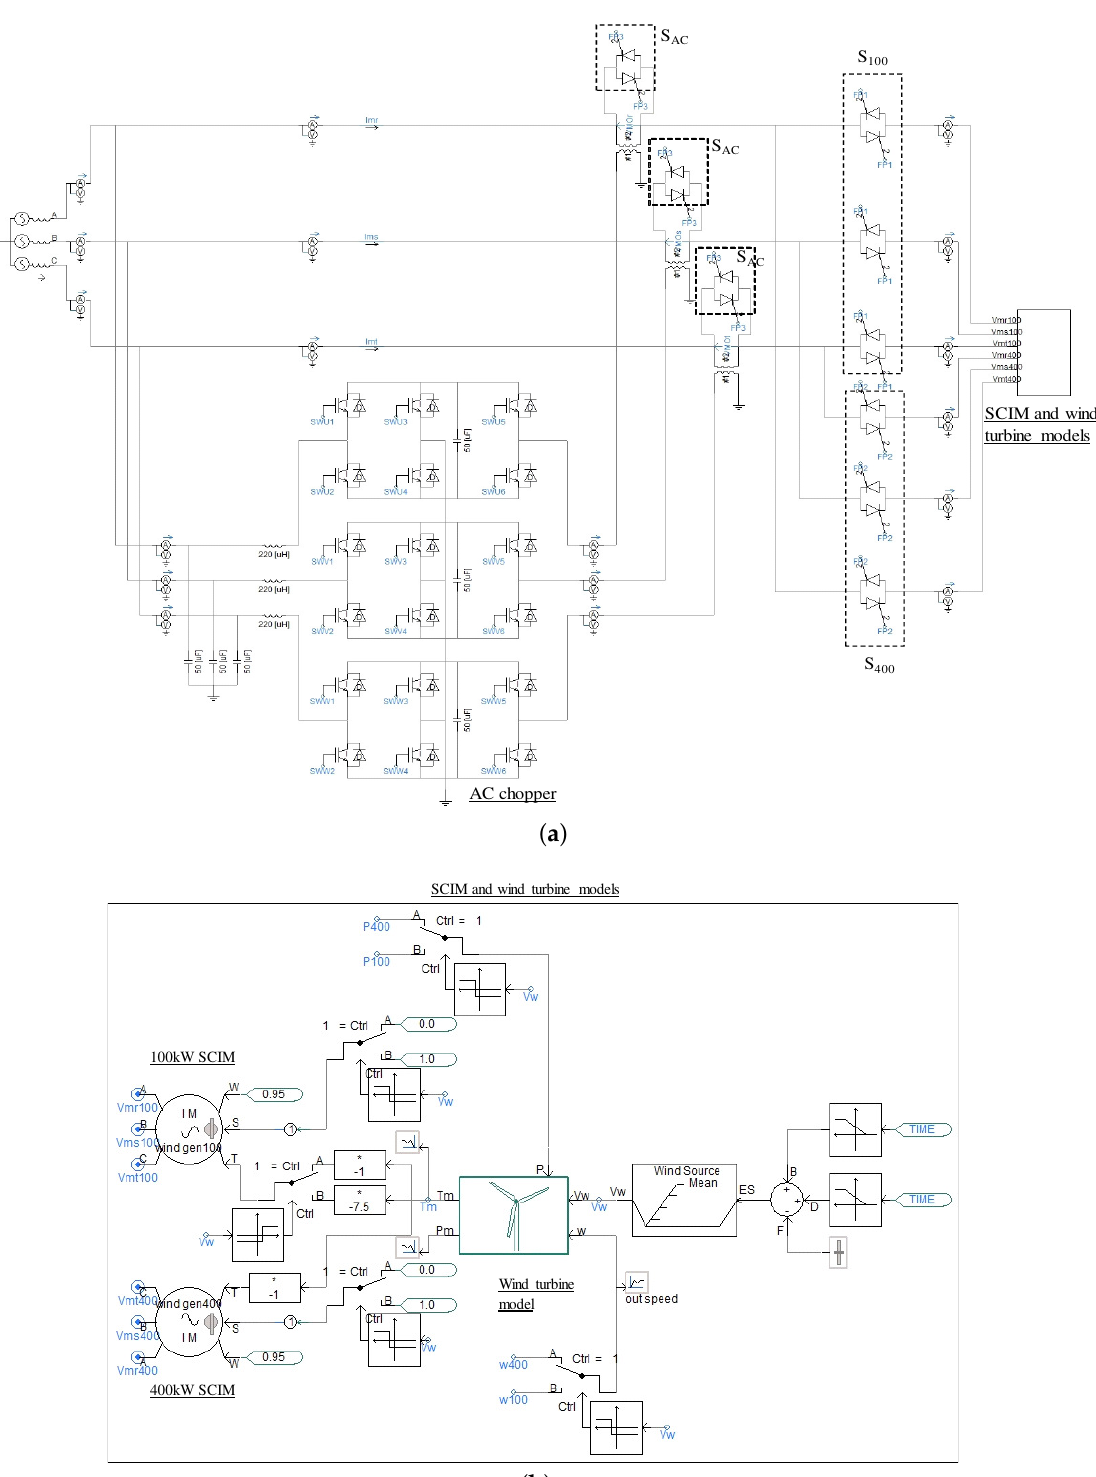
Figure 5. Simulation model of the proposed inrush current suppressor on the power system computer-aided design/electromagnetic transients including DC (PSCAD/EMTDC). ( a ) Power circuit of the proposed inrush current suppressor; ( b ) magnified figure of SCIMs and wind turbine models in ( a